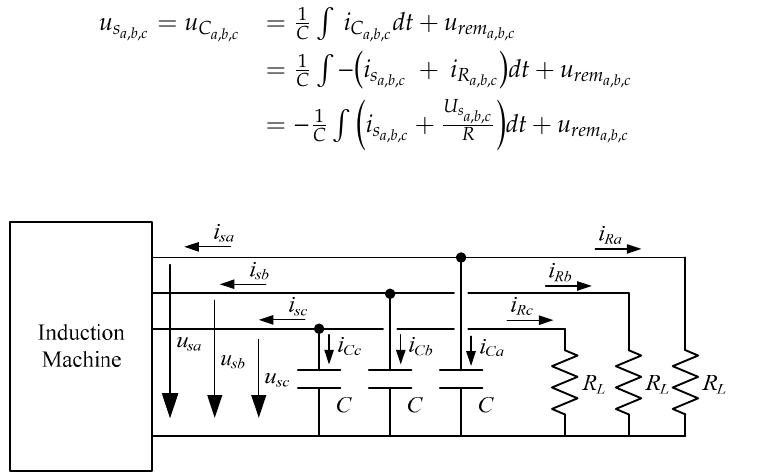
Figure 4. Connection between induction machine, capacitors and resistive load.